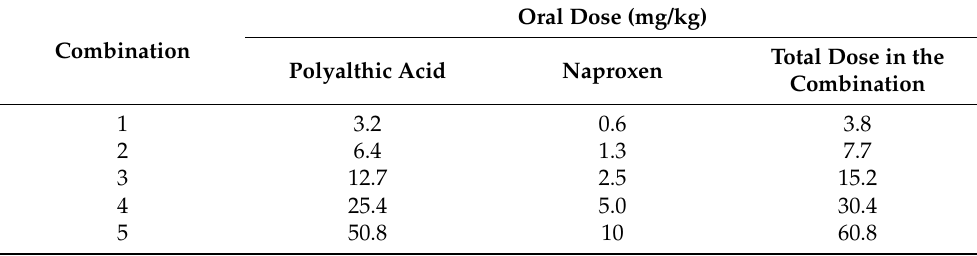
Table 1. The following doses of the combination treatment (Polyalthic acid + naproxen) were orally administered to rats evaluated with carrageenan-induced hyperalgesia. The results were used to construct a dose–response